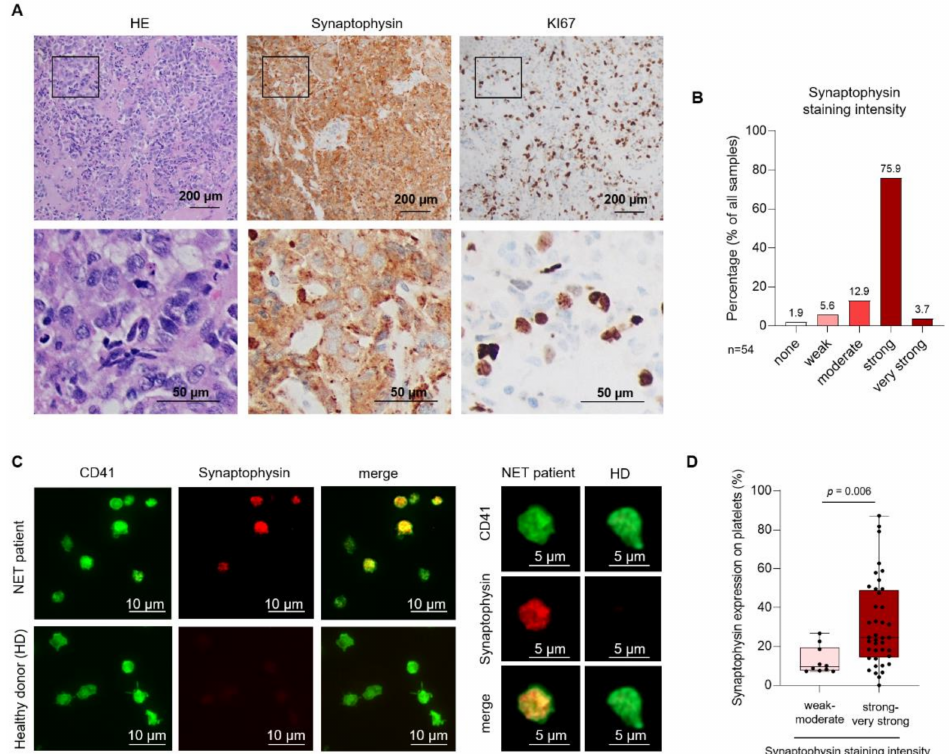
Figure 1. Expression of Synaptophysin in tumor tissue and platelets derived from neuroendocrine neoplasm (NEN) patients. ( A ) Representative HE, Syn, and Ki67 staining in a NET G2 patient. The proliferation index (Ki67) was calculated as 10%. Images taken at 10 × magnification. ( B ) Relative Syn staining intensity in the NEN cohort of 54 patients. ( C ) Immunofluorescence analysis of platelet- expressed Syn (labeled in red) in a NET G3 patient and a HD. Platelets were identified via CD41 (labeled in green). Images taken at 60 × magnification. ( D ) Correlation of synaptophysin expression on platelets and synaptophysin staining intensity in tumor